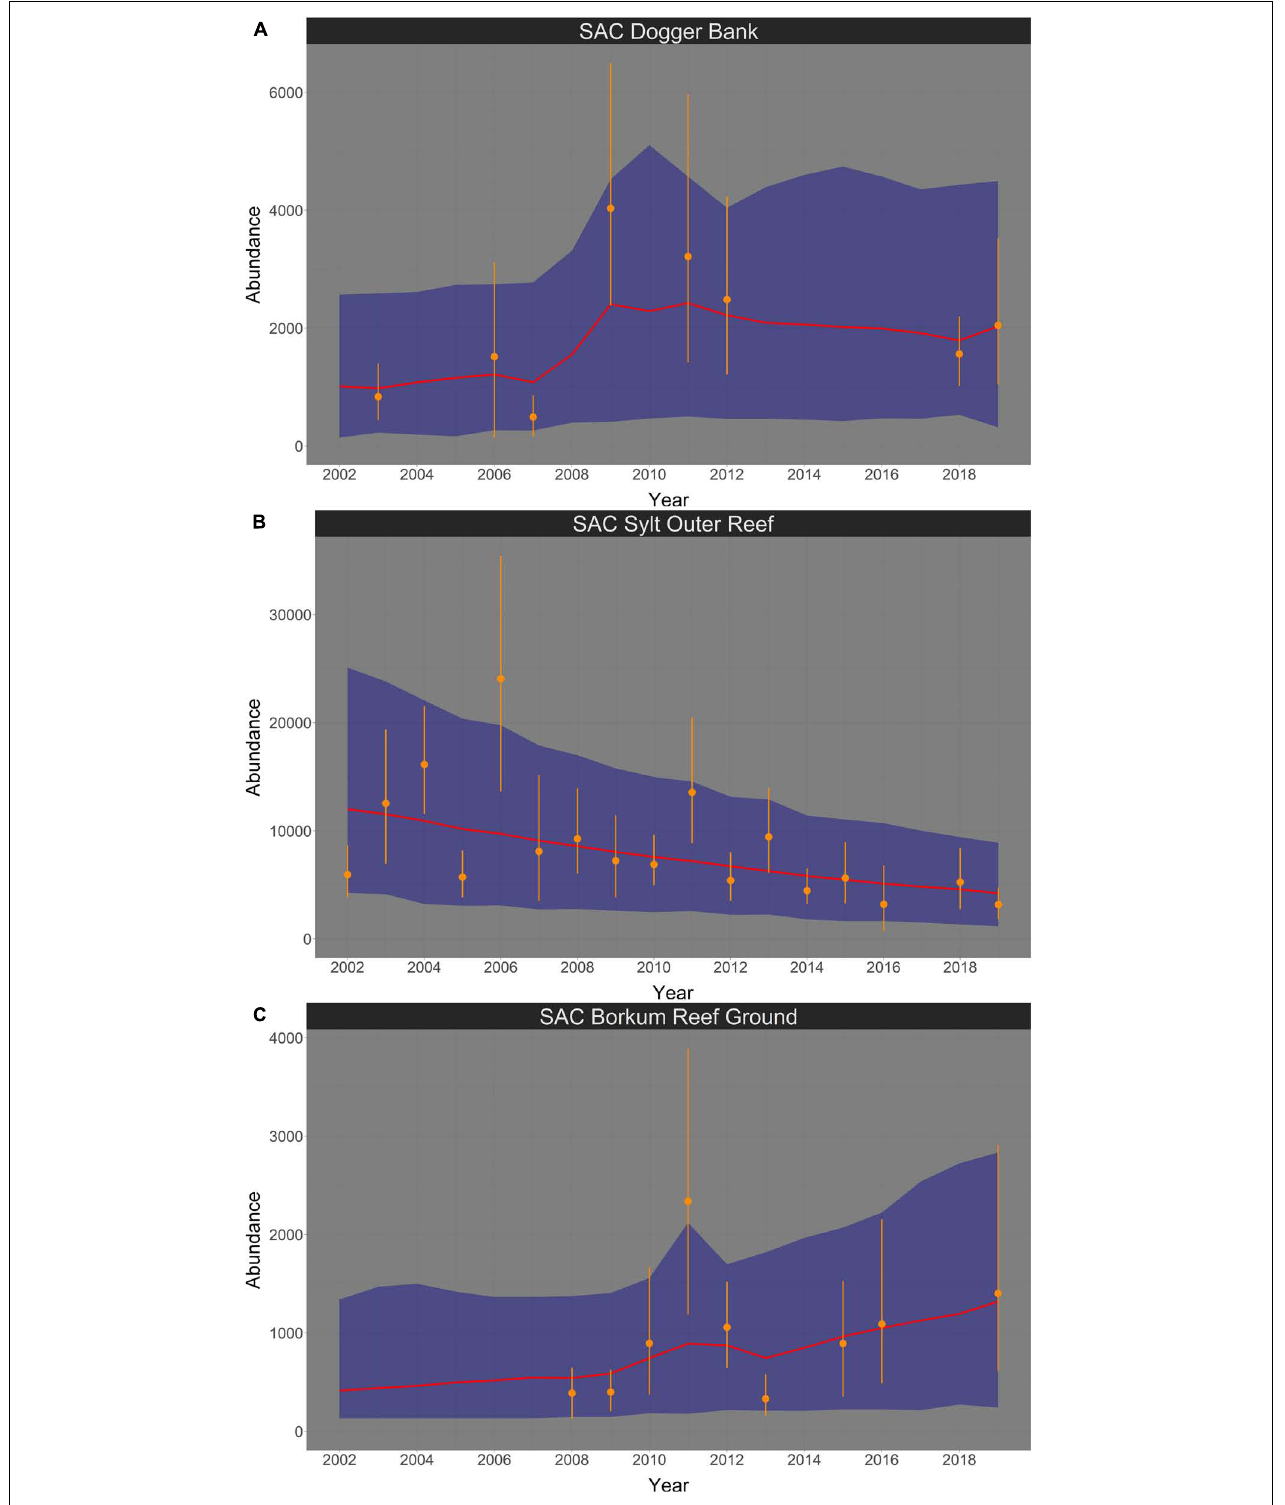
FIGURE 9 | Bayesian abundance trend analysis for harbour porpoises in the three SACs Dogger Bank (A) , Sylt Outer Reef (B) , and Borkum Reef Ground (C) , based on post-stratified aerial survey data in summer, between 2002 and 2019. Orange dots illustrate stratum-based abundance estimates and orange lines the associated 95% CI. The red line shows the median of the posteriori distribution of the calculated ‘true’ abundances from the Bayesian model, the blue shaded area displays the corresponding 95% credibility intervals. Please note in all figures the y -axis is free.